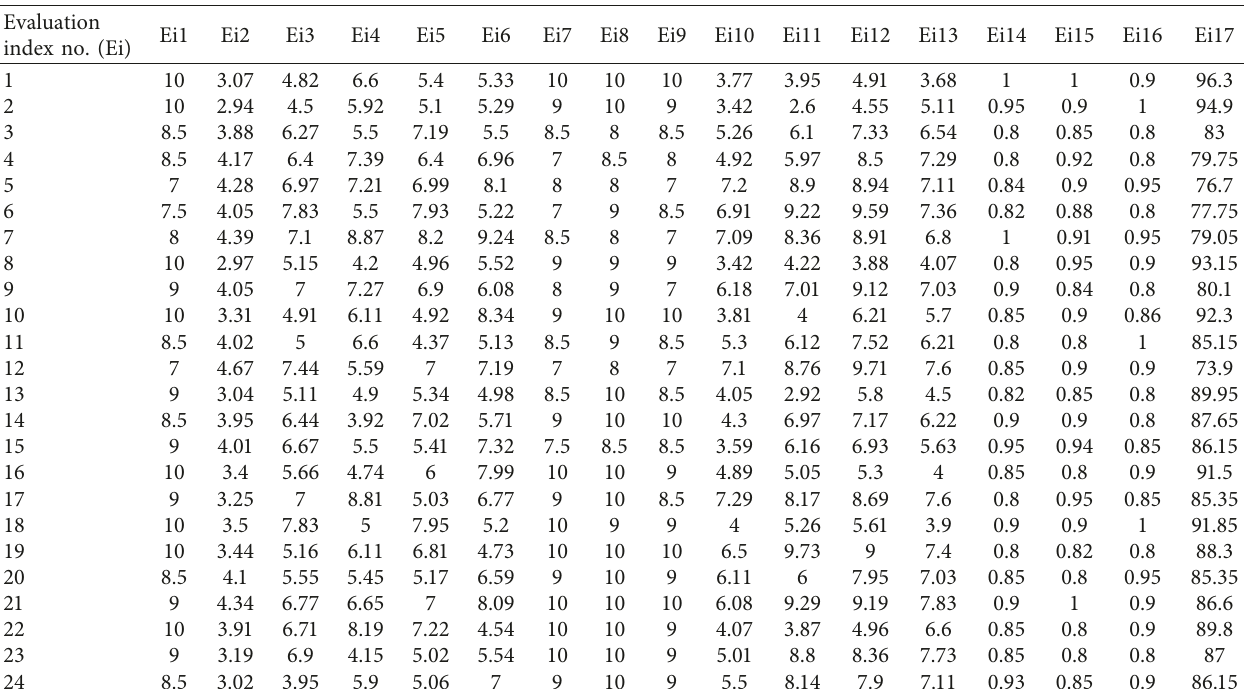
Table 3: BP neural network sample